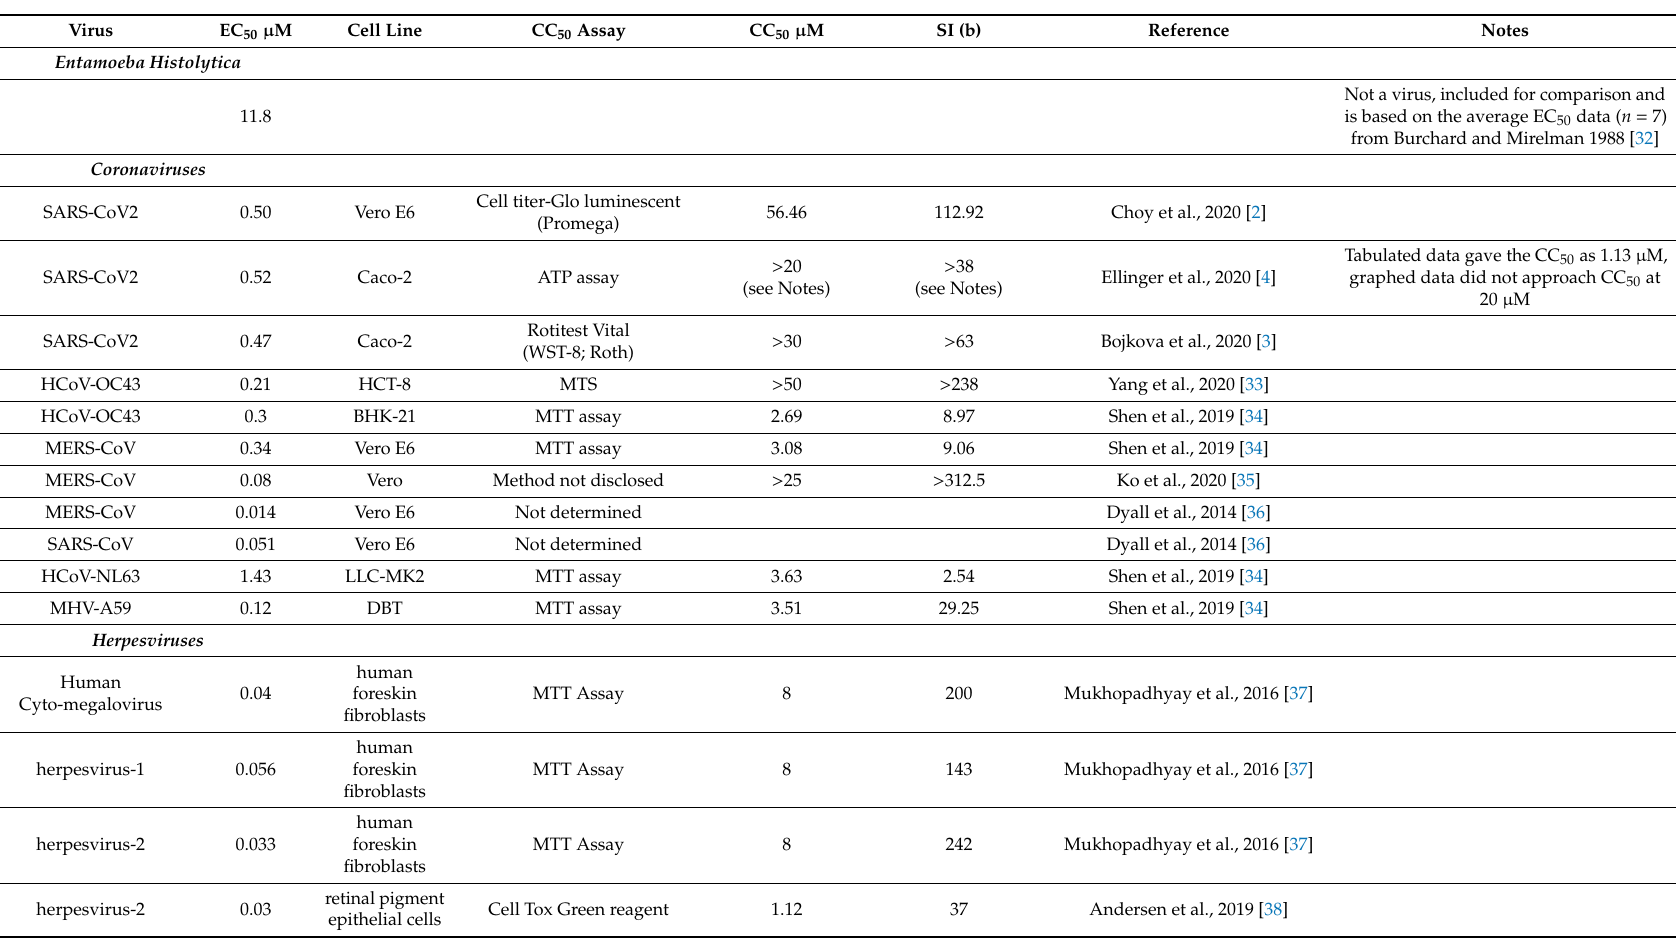
Table 1. EC 50 values of emetine against various viruses. The majority of the viruses have an EC 50 value in the low-nM range. For comparison purposes the EC 50 value of Entamoeba Histolytica is included. Most viruses have an EC 50 value 20–300 times less than Entamoeba Histolytica, indicating that much lower doses would be required for antiviral treatment than the doses used for the treatment of amoebiasis. The half-maximal cytotoxic concentration (CC 50 ) and the selectivity index (SI) data is included to demonstrate that the in vitro toxicity, as represented by the CC 50 , varies dramatically and that the concentrations are often substantially lower than the likely concentration achieved in practice see Supplementary File, Table S1. The in vitro CC 50 appears to have little resemblance to what is seen in